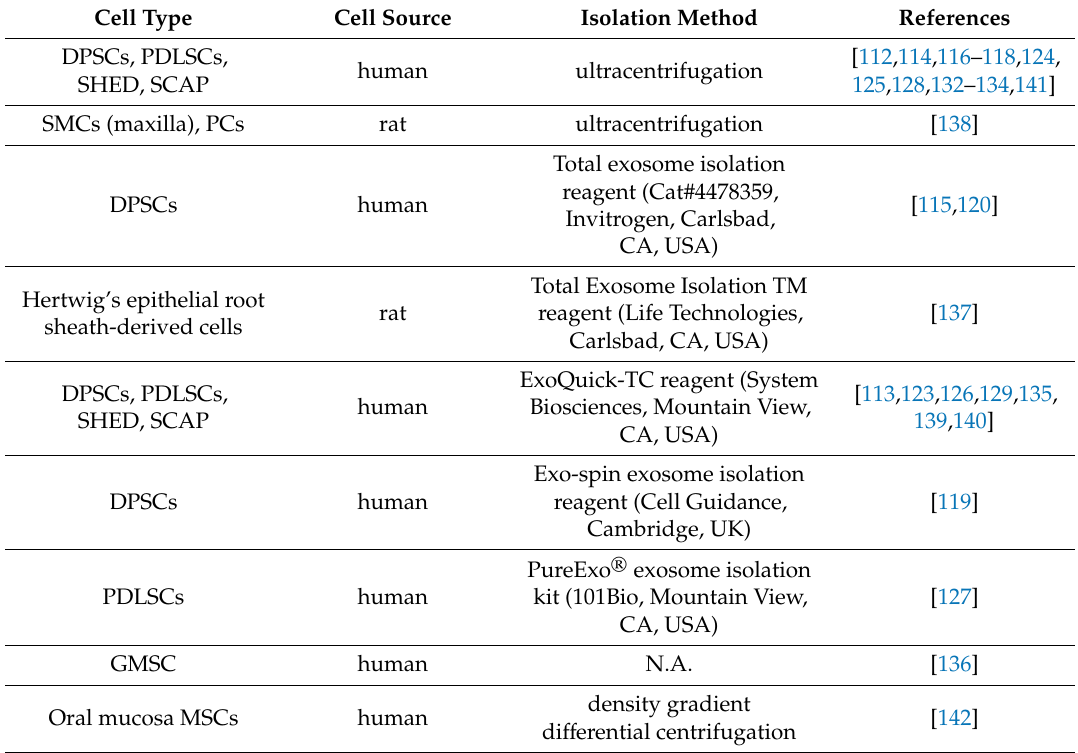
Table 1. Recent key studies with methodology for oral MSCs-derived exosomes